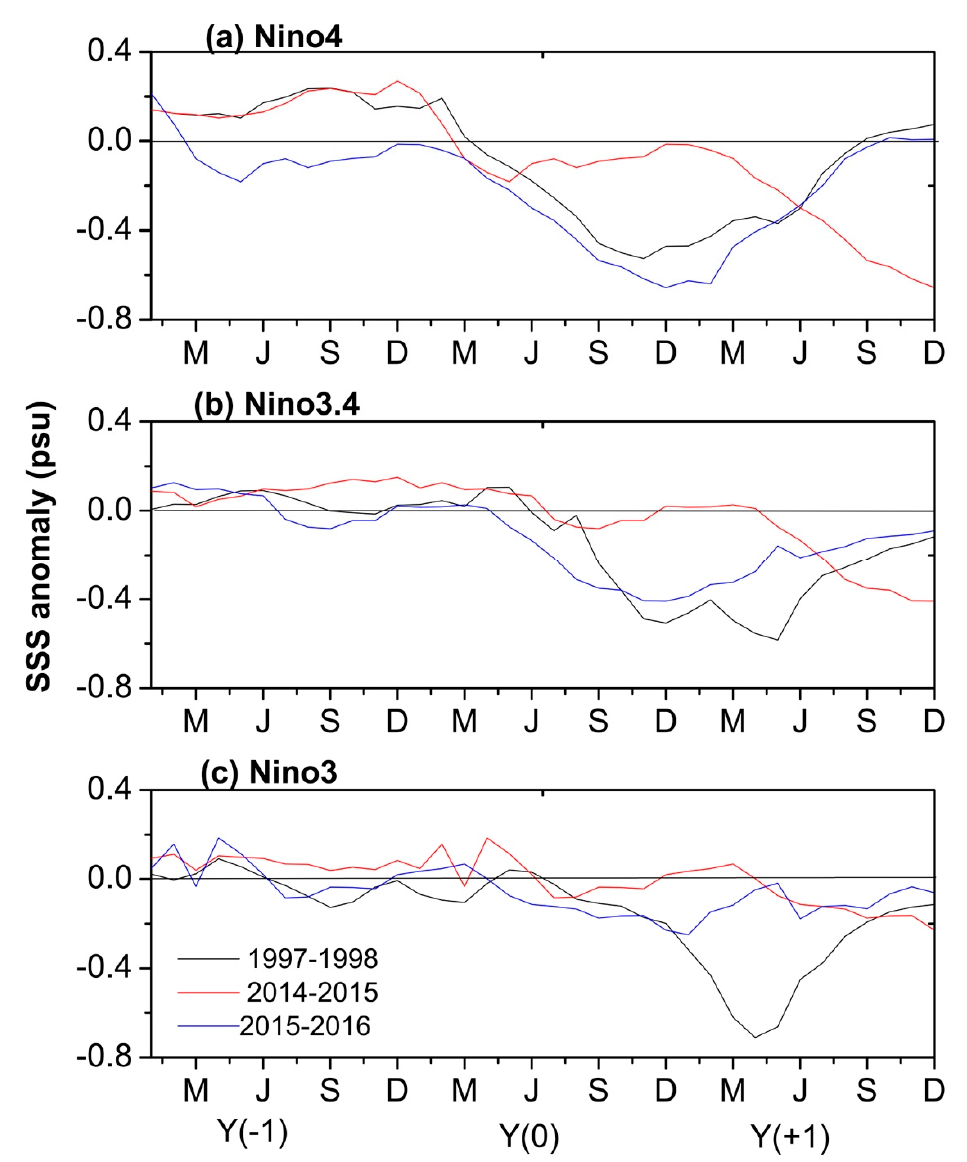
Figure 3. Seasonal variability of SSS anomalies for El Niño events (ENs) in 1997–1998 (black), 2014–2015 (red) and 2015–2016 (blue) in ( a ) Niño 4, ( b ) Niño 3.4, and ( c ) Niño 3 boxes. The black line represents zero. The units for SSS are psu.